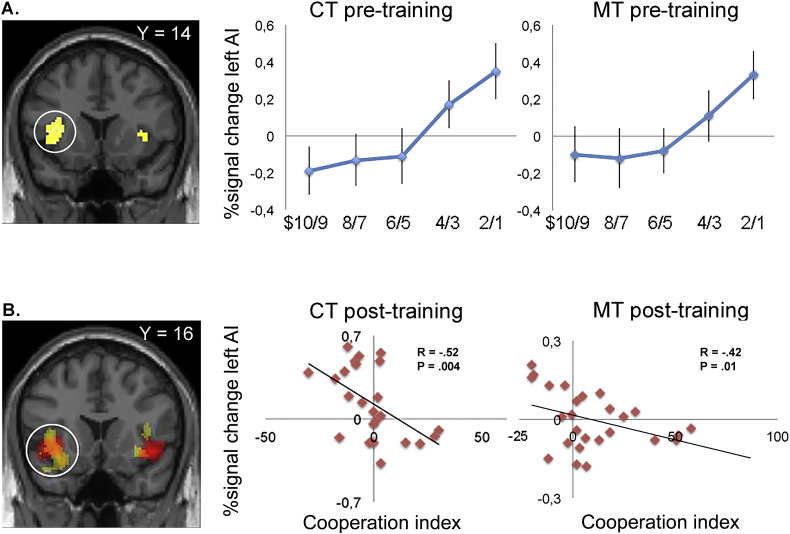
A) Conjunction analysis across groups (MT and CT) in the pre-training condition. Significant conjunction effect between the mindfulness and control group in bilateral anterior insula (AI) displayed at p < 0.001, uncorrected. The beta plots from the left AI (circled) display a linear scaling with the size of unfair offers in both the MT group and in the CT group. Mean ± SEM are plotted in increments of $2 bins.B) Cooperation index across groups in the post-training condition. fMRI correlational analysis in the left AI. Regions showing a significant correlation between the cooperation index (calculated as a between-subject measure of the difference in behavioral acceptance rate from pre- to post-training). The left AI is circled and activation maps for both groups are overlaid on a coronal T1-weighted slice displayed at (p < 0.005, uncorrected) to illustrate overlap in activation between the two groups (MT group in red; CT group in yellow). Plots of correlation are displayed separately for MT group and CT group. Each data point represents a subject.